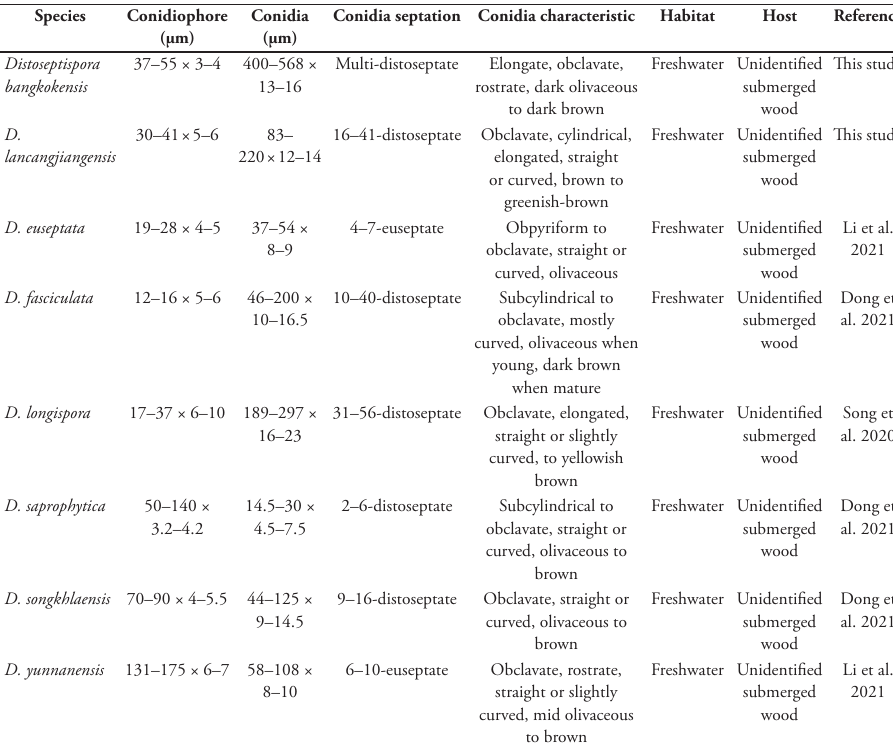
Table 2. Comparison of morphological characteristic, habitats and hosts’ information of species added to Distoseptispora after Monkai et al. (2020) (for other species see Monkai et al. 2020).